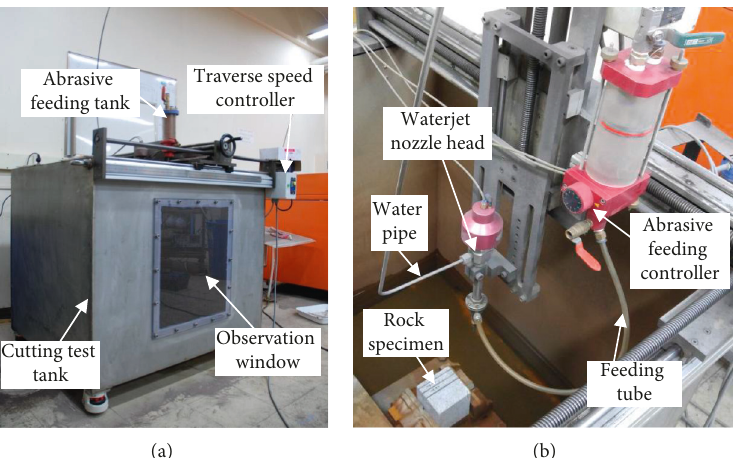
Figure 1: Test setup for abrasive waterjet rock cutting: (a) cutting test tank with a traverse speed controller; (b) rock cutting test setup in the cutting test tank.